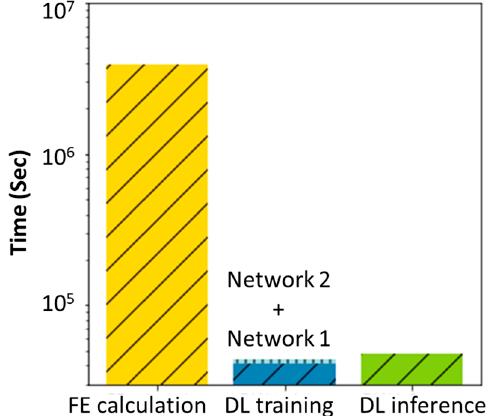
Figure 7. The computational time of tissue differentiation prediction for all 900 cases needed by FE calculation and DLN.